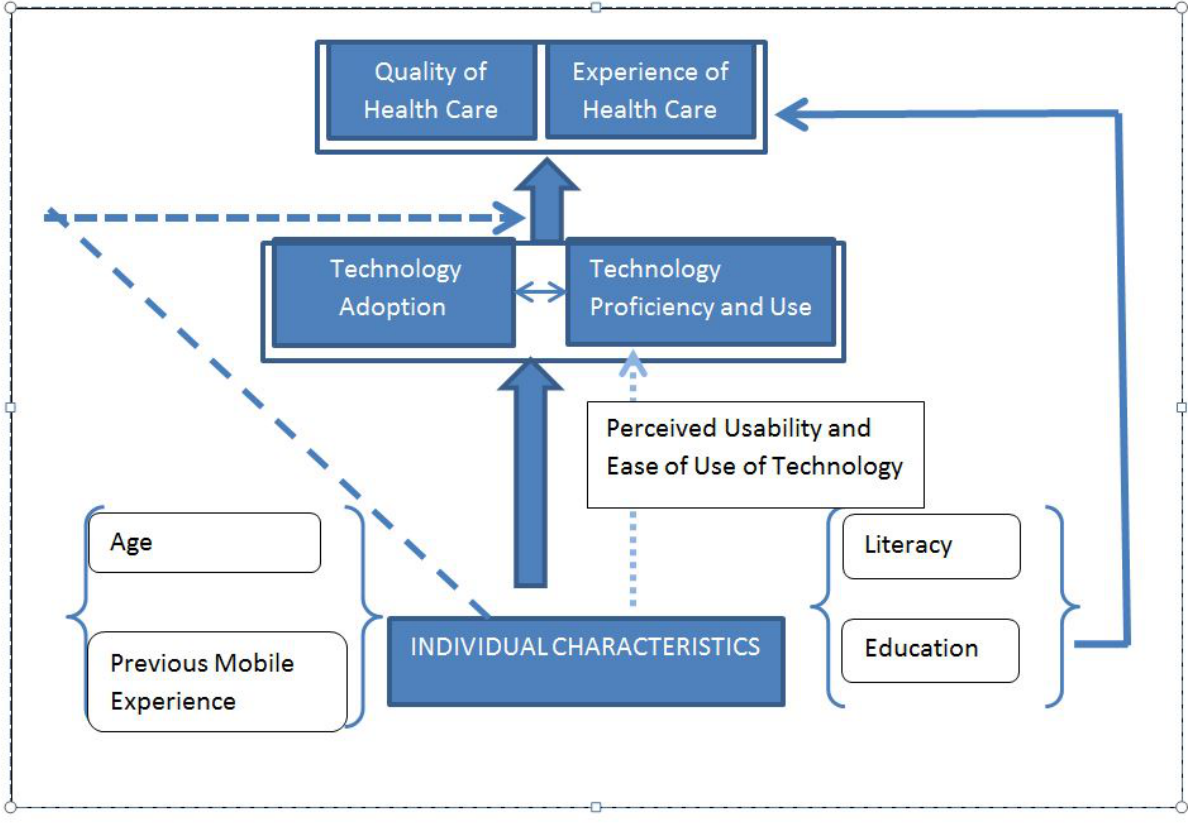
Figure 2. Analytical framework. The flowchart shows the relationship between mHealth technology adoption and usage, and quality and experience of care. The level of technology adoption can affect the quality and experience of care provided by CHWs because of the design and content of the app. Individual factors, including literacy, education, age, and previous mobile experience, are seen as mediating factors for mHealth technology adoption and usage. They influence the quality and experience of care by affecting the way CHWs leverage the technology to do their jobs. Literacy and education can also directly influence the quality and experience of care delivered by the